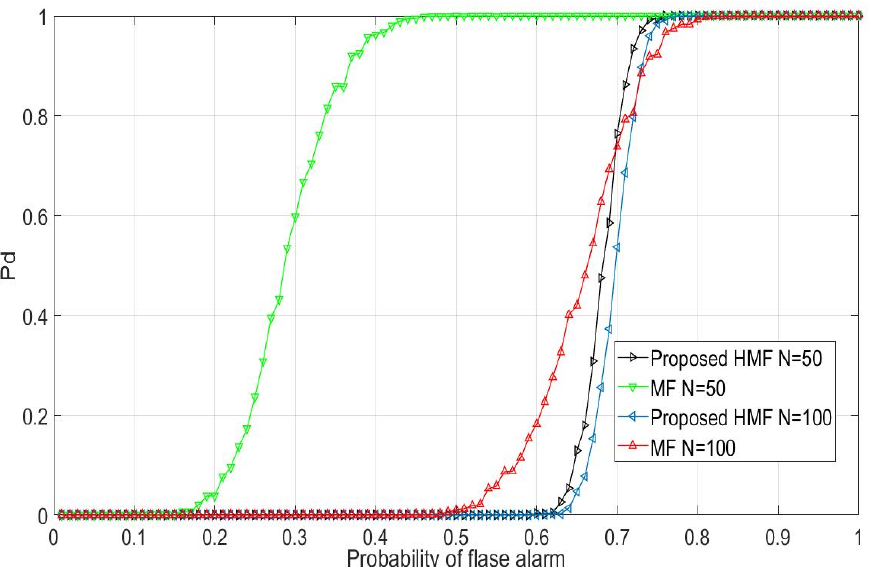
Figure 6. Performance of probability of detection and probability of false alarm for HMF and MF, considering number of samples = 50 and 100 in the Rayleigh Channel.